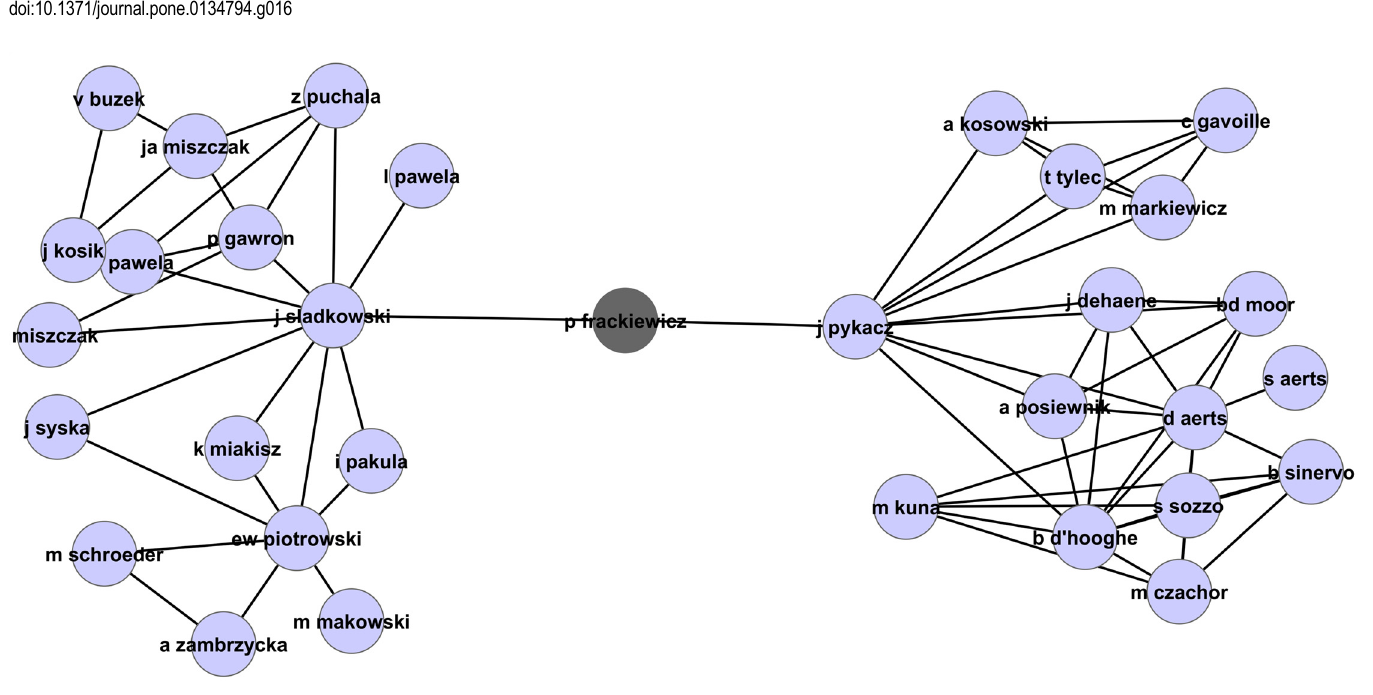
Fig 16. Part of the collaboration network highlighting the prominent authors from the Quantum Game Theory Google Scholar profile. The details of the highlighted authors are listed in Table 2.